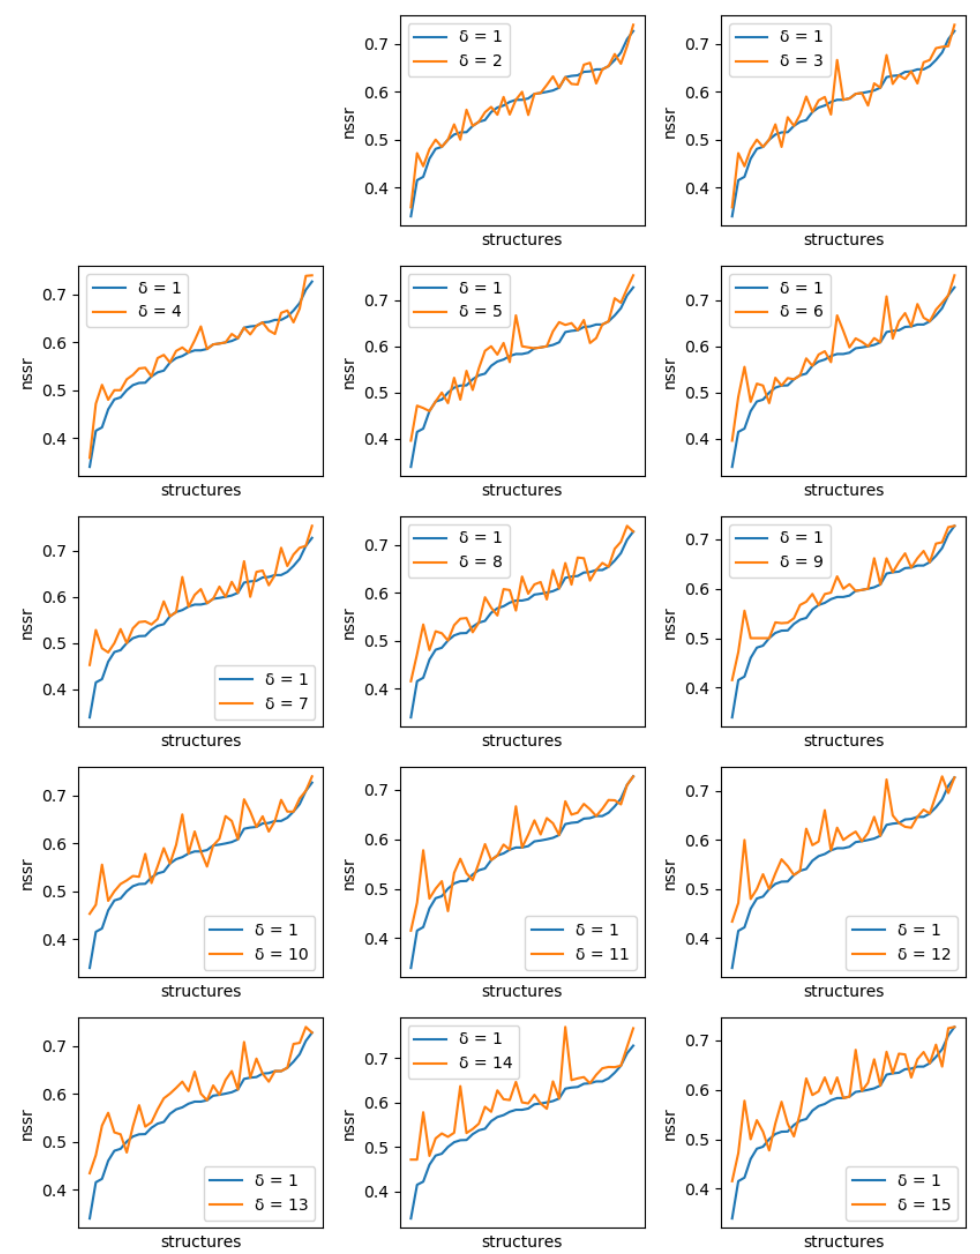
Figure 11. Comparison of the best NSSR value obtained with ten 1-diverse sequences ( δ = 1, blue curve) with the best NSSR value obtained with libraries of ten sequences of increased diversity all predicted with an allowed gap top optimal energy of 3 kcal/mol. Each plot corresponds to a specific additional value of δ ( δ = 2 to 15, golden curve). Plots are lexicographically ordered from top-left to bottom-right, with increasing values of diversity ( δ ). In each plot, the X-axis ranges over all tested backbones, sorted in increasing order of NSSR value for the 1-diverse case and the Y-axis gives the corresponding NSSR value. As the diversity requirement δ increases, the NSSR value indicated by the golden curve increases also